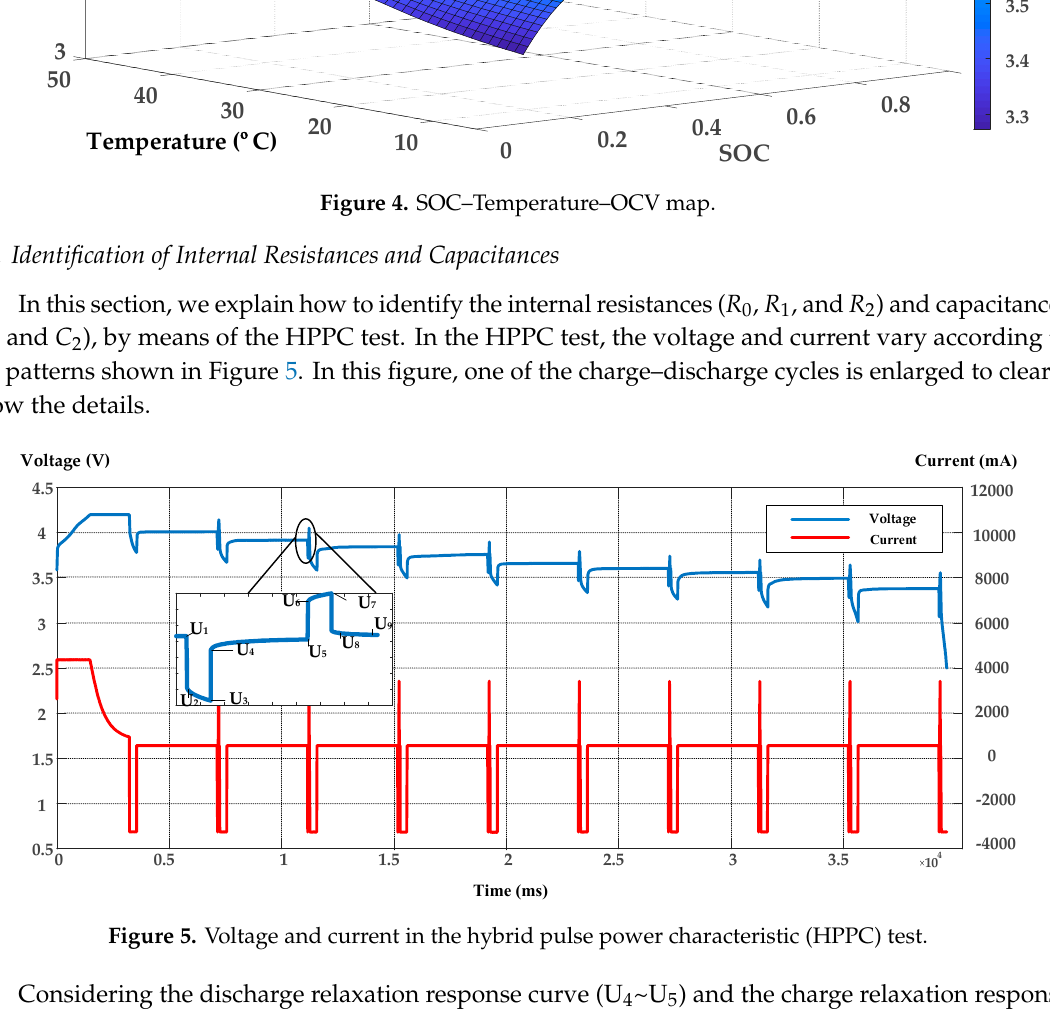
Figure 2. The five coefficients a , b , c , τ 1 , and τ 2 in Equation (9) can be obtained by means of curve fitting using MATLAB